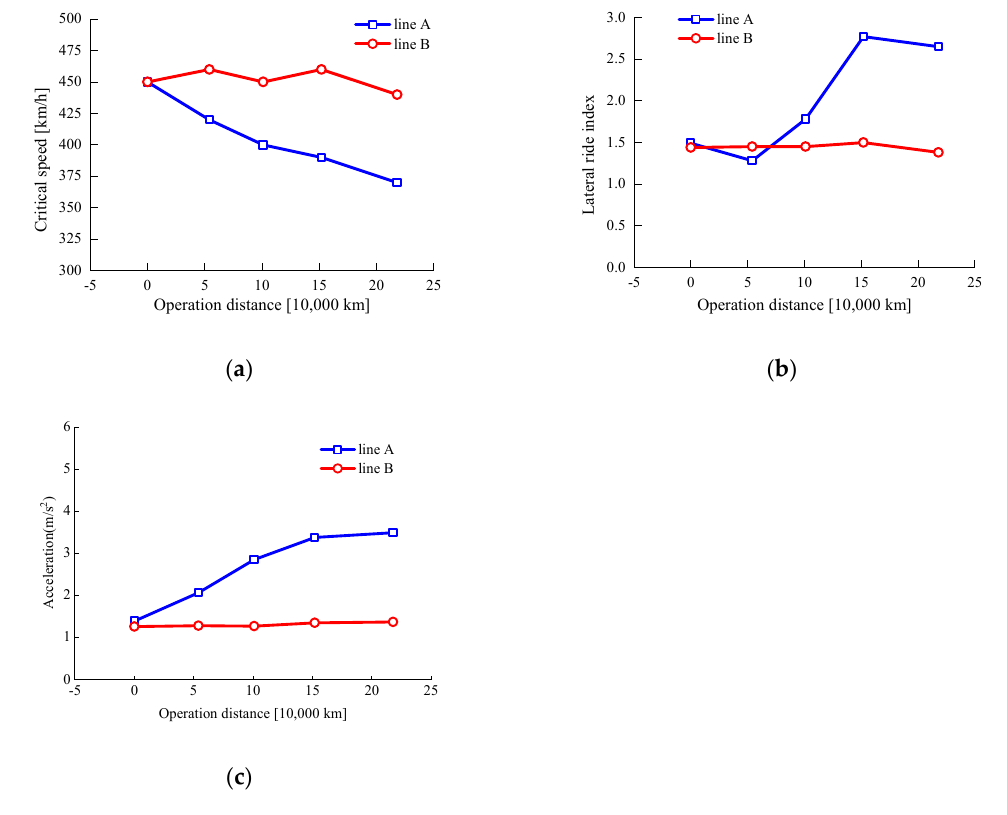
Figure 10. Vehicle dynamics index. ( a ) critical speed; ( b ) lateral ride index and ( c ) carbody